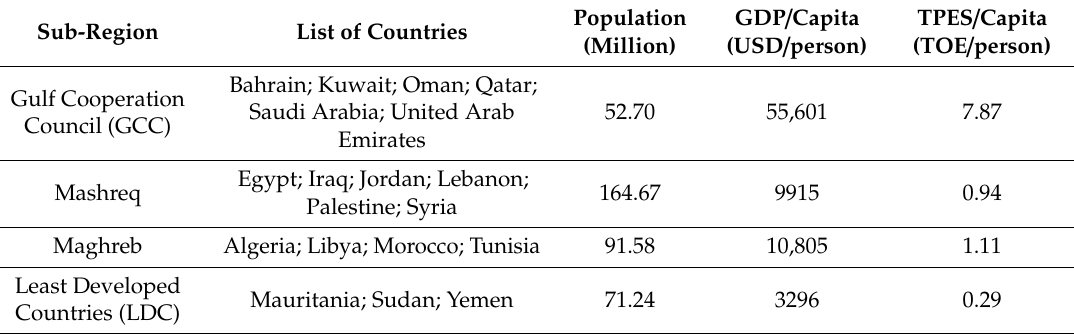
Table 1. Characteristics of Arab sub-regions including countries, population, GDP per capita, and TPES per